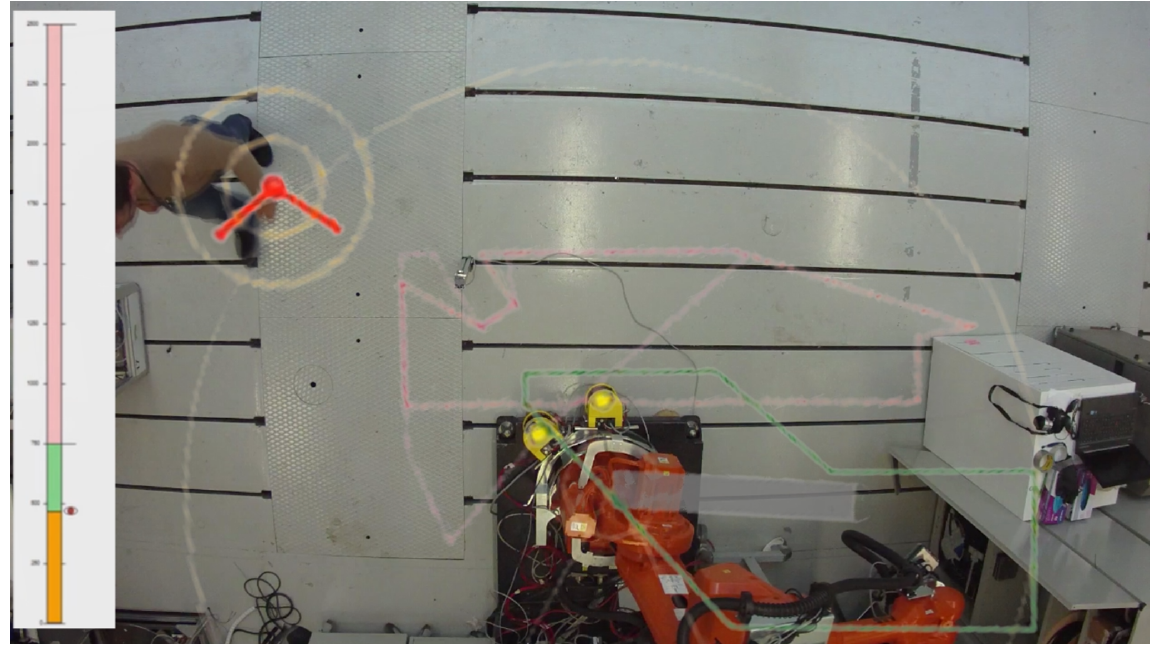
Figure 5: Photograph of the information display, which shows on the left a detected person, in the middle safety zone (red), on the right bottom robot allowed space (green) and the large circle shows the current safety speed